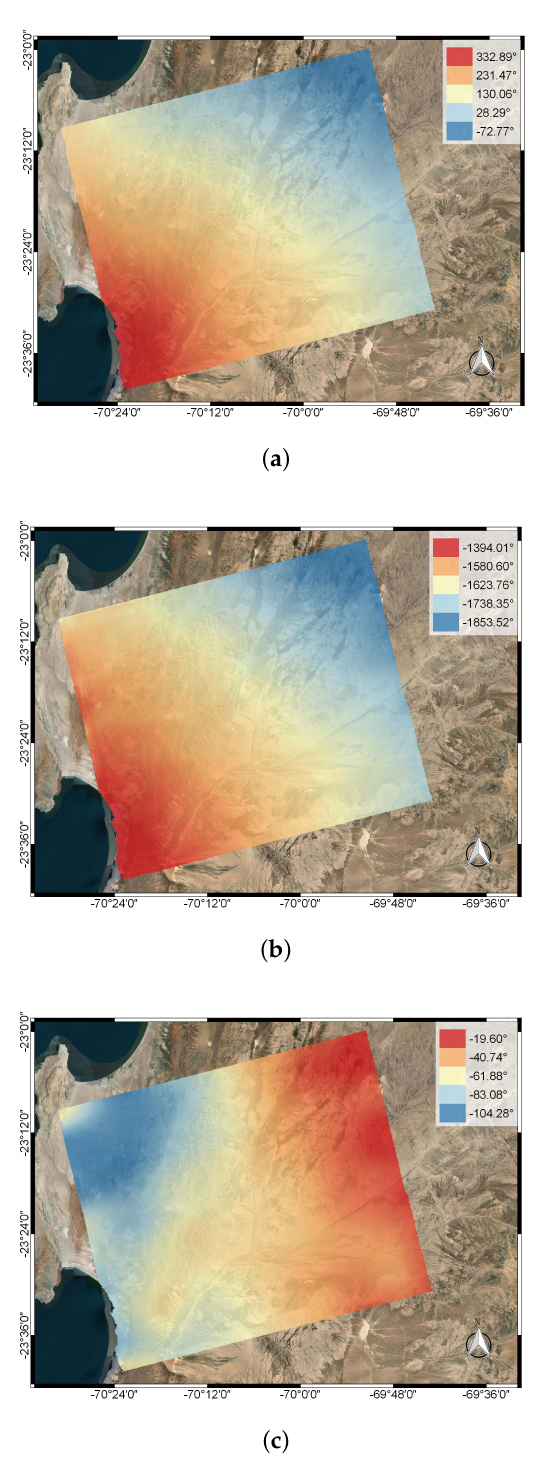
Figure 13. Ionospheric correction by SSM on 20100623 and 20100808: ( a ) Original DInSAR phase. ( b ) Ionospheric phase delay. ( c ) Corrected DInSAR